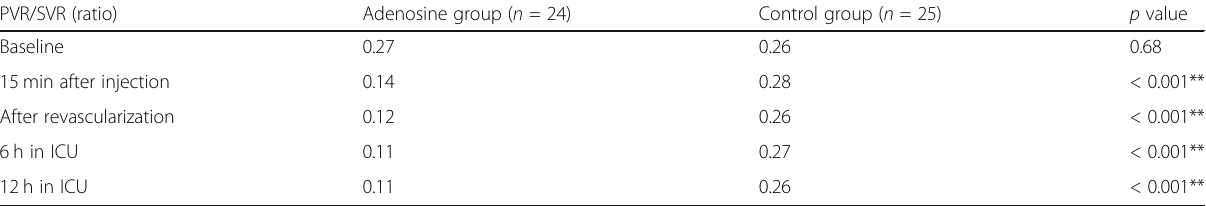
Table 3 The ratio of pulmonary vascular resistance (PVR) to the systemic vascular resistance (SVR)